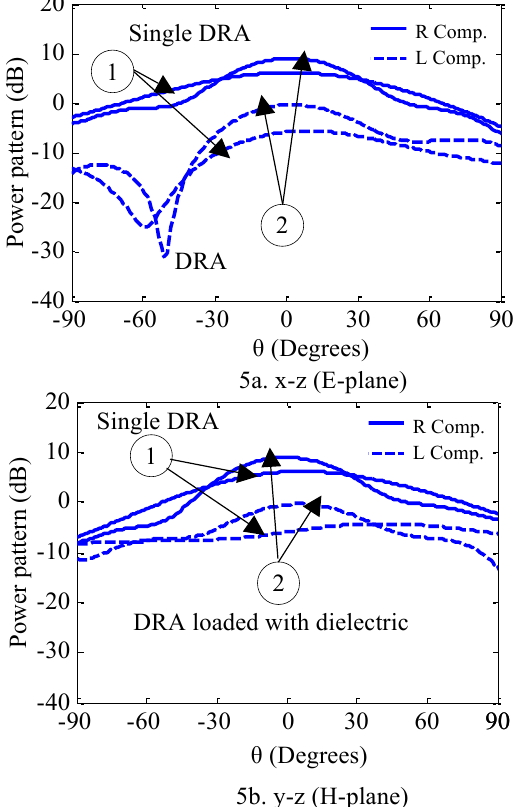
Figure 5: The E- and H- planes of circular polarization radiation patterns for the DRA loaded with the dielectric slab compared to a single DRA at f = 10 GHz